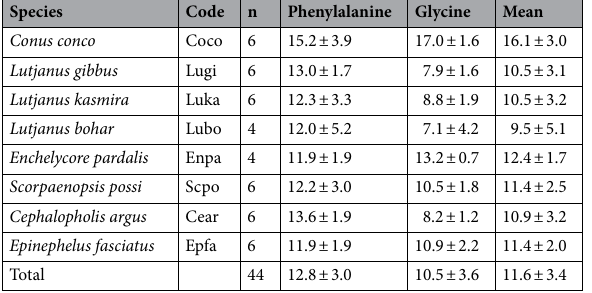
Table 2. Source amino acids (AA) δ 15 N values (‰) of eight secondary consumers (means ± standard deviation), both seasons